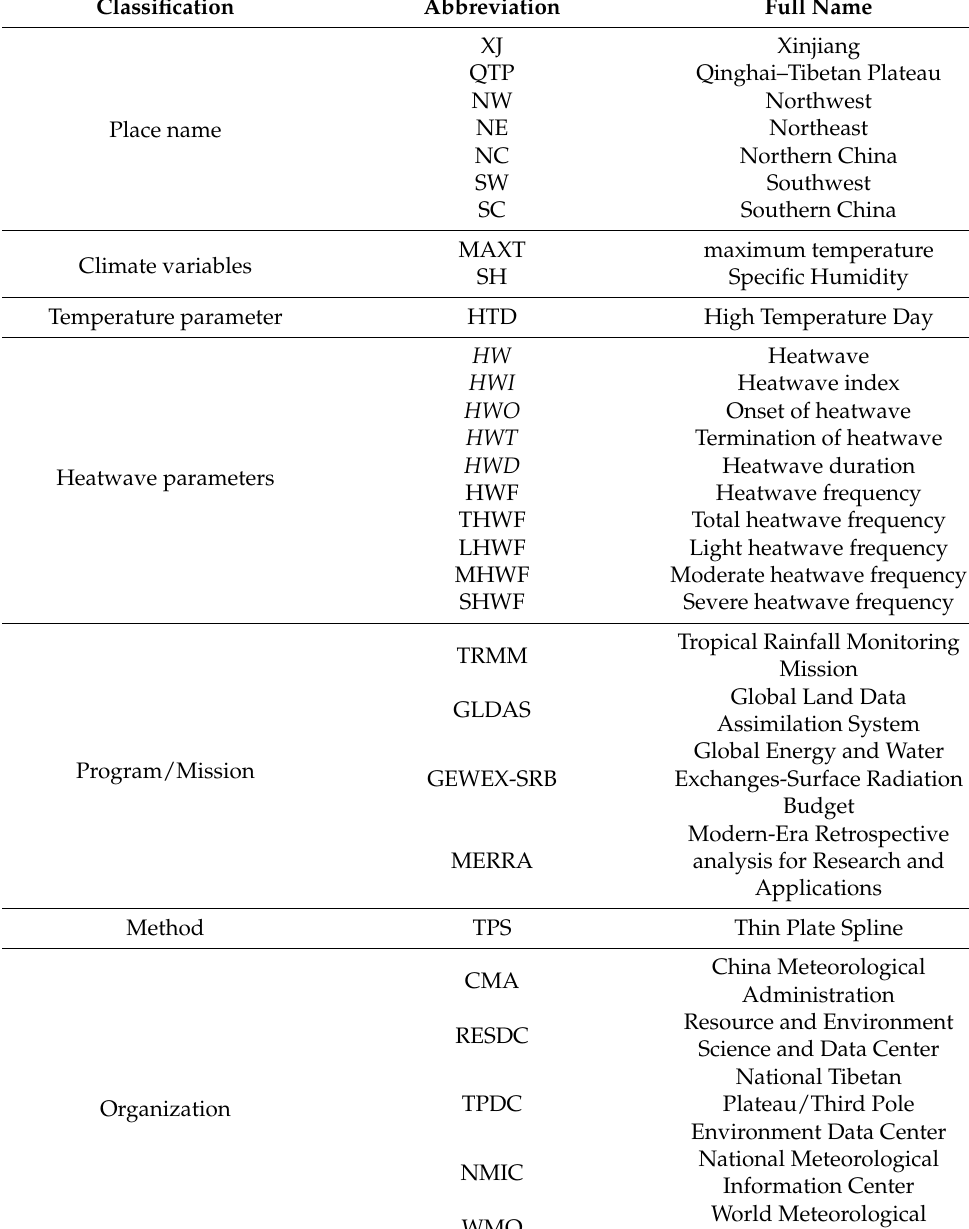
Table A1. All abbreviations and corresponding full names presented in this